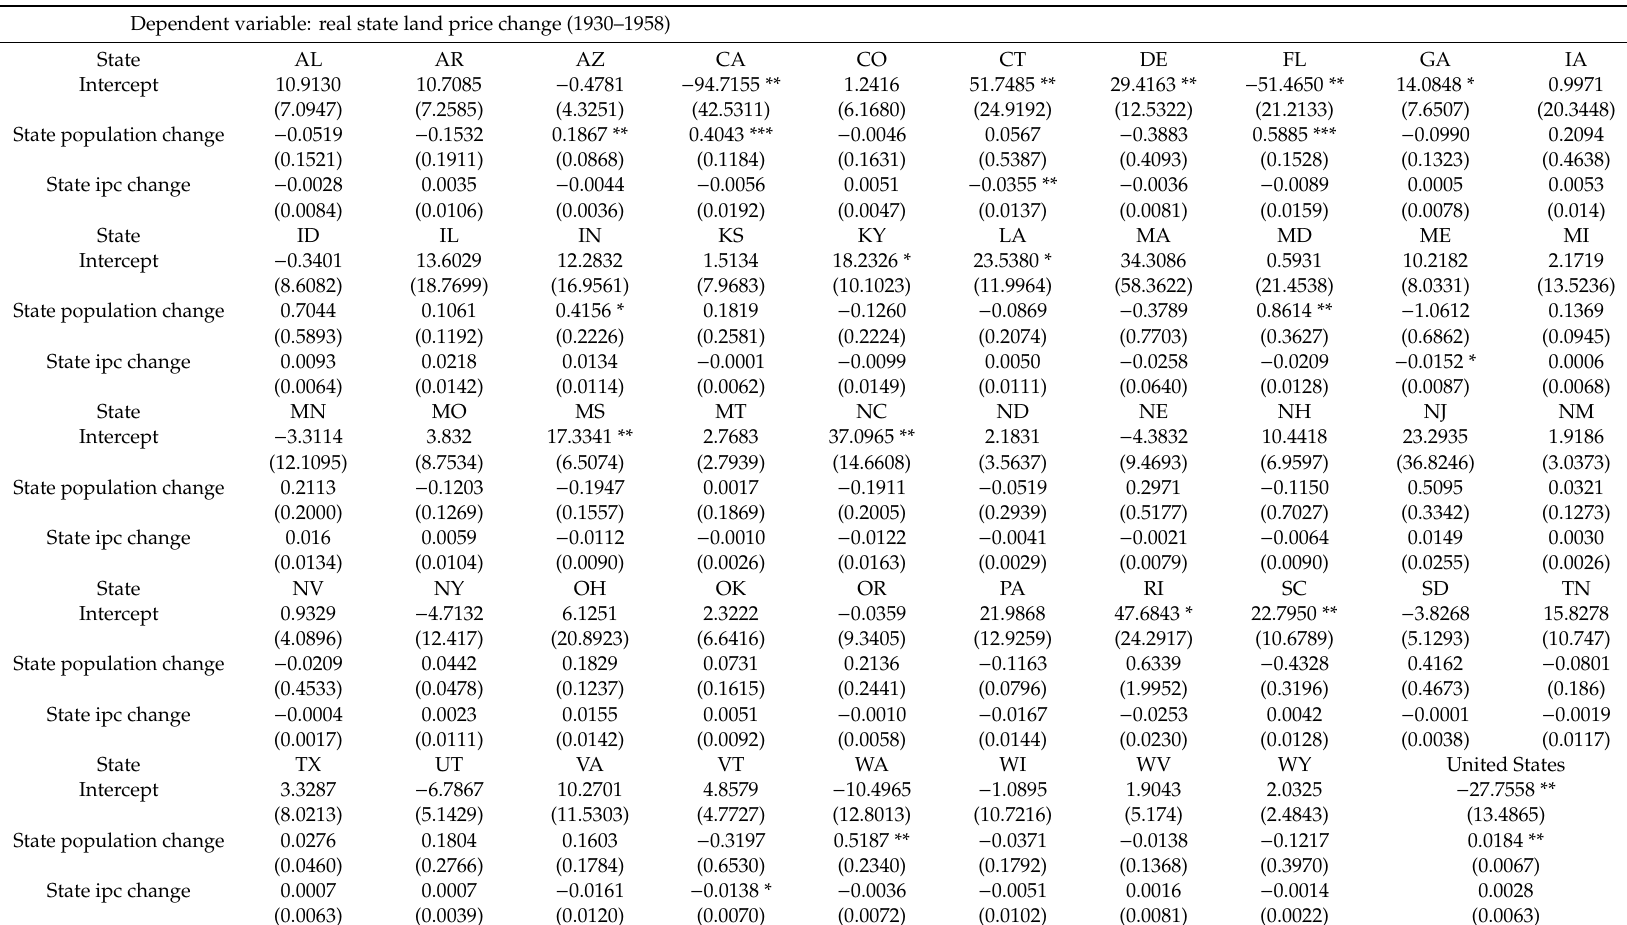
Table 4. The impact of state level population growth and income per capita growth on agriculture land price growth (1930–1958), real variables. Dependent variable: real state land price change